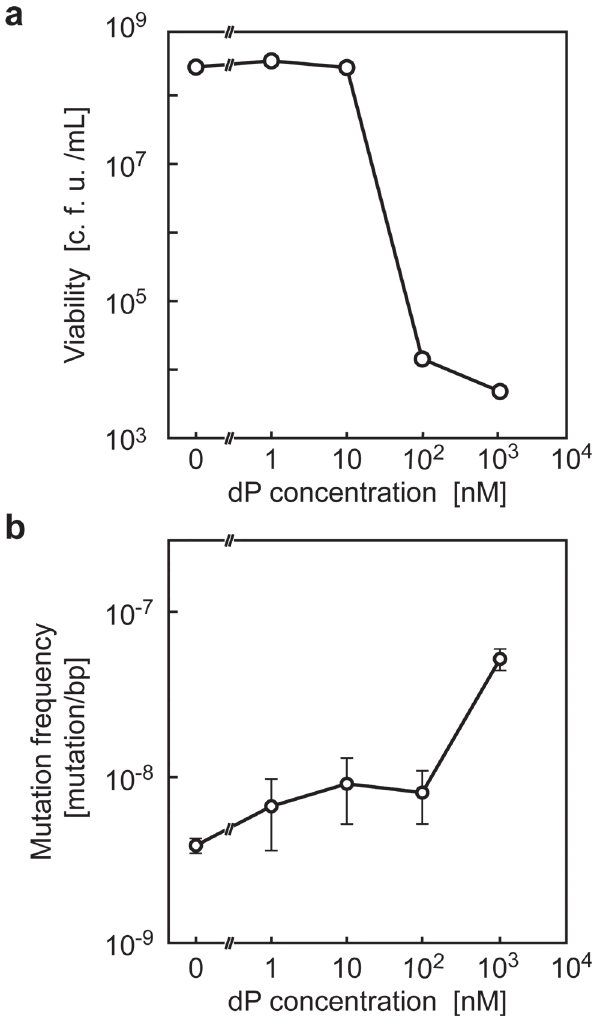
Fig 2. dP/hsvTK counter-selection. (a) Host-killing efficiency of dP-selection with different dP concentrations for E . coli strain MG1655 Δ lacZ :: hsvtk-cat harboring pKD46. (b) Mutation frequency of E . coli strain MG1655/pKD46 in the media containing varying concentration of dP. The bar heights show the average of 3 samples, and error bars indicate the standard deviation.